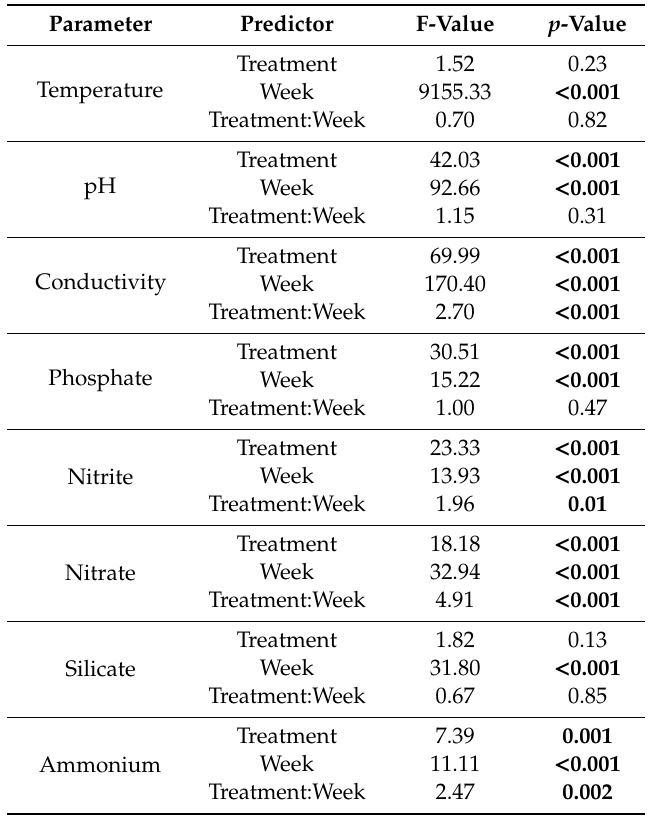
Table 1. Linear mixed e ff ects model results considering measured water parameters as a function of leaf treatment and week , and their interaction. F-values are discerned with Type III sums of squares via Satterthwaite’s method. Significant p -values are